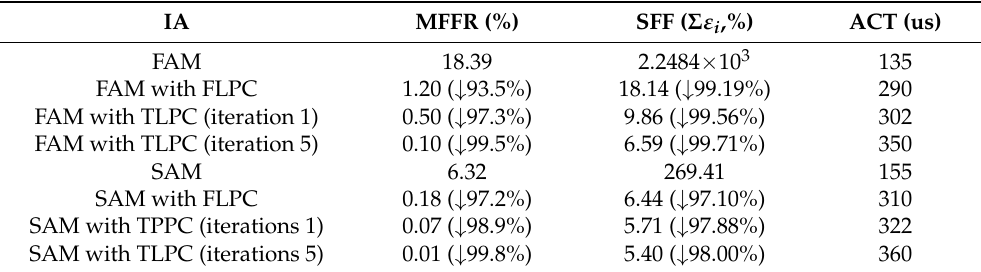
Table 1. Simulation results of the proposed parameter compensation interpolation